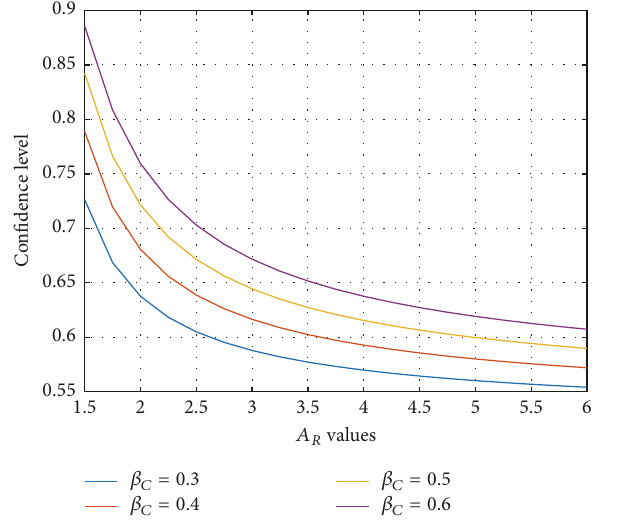
Figure 3: Confidence levels of exact DF for SDCs 3, 4, and 5 for the range of 𝐴 𝑅 and 𝛽 𝐶 values.